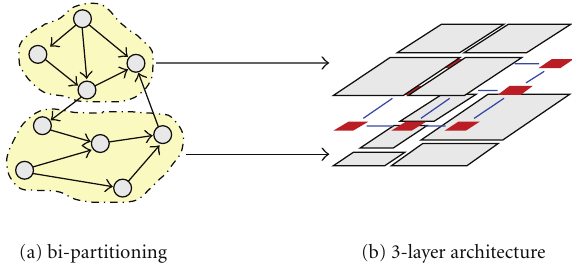
Figure 4: Bipartitioning of the application communication task graph and assignment of the two partitions to layers 1 and 3 of the 3-layer